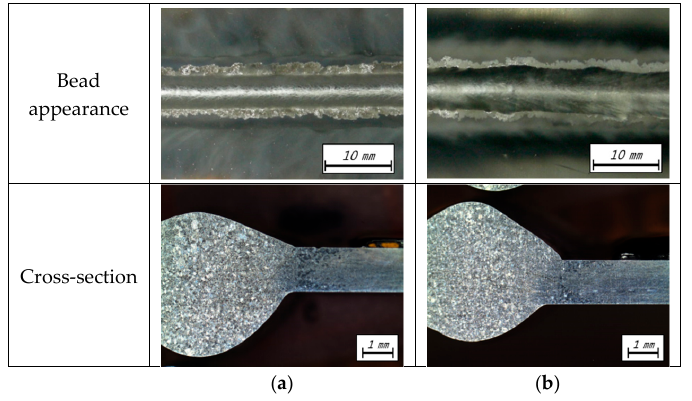
Figure 4. Bead shapes for bead ‐ on ‐ plate (BOP) welding: ( a ) AZ31 ‐ A; ( b ) AZ31 ‐ B.